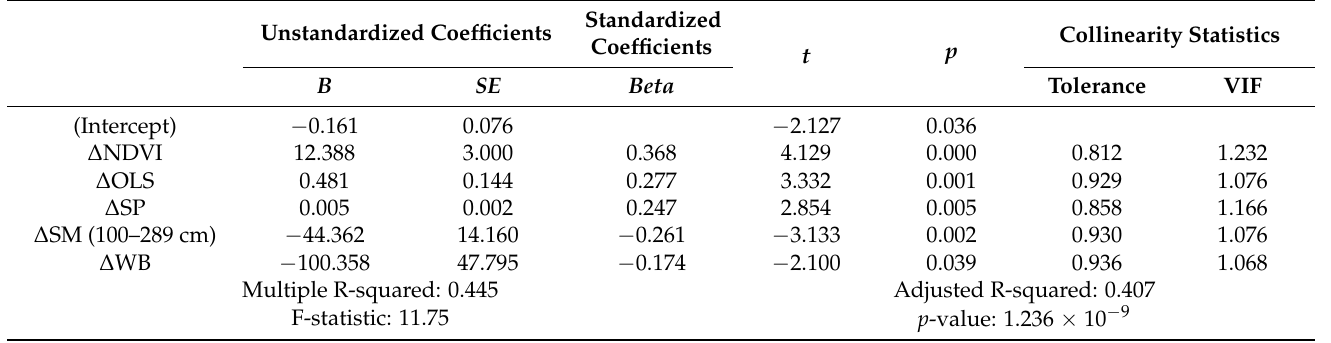
Table 3. Stepwise regression analysis. Dependent variable: ∆ AST. The definitions of the abbreviated variables can be found in Table